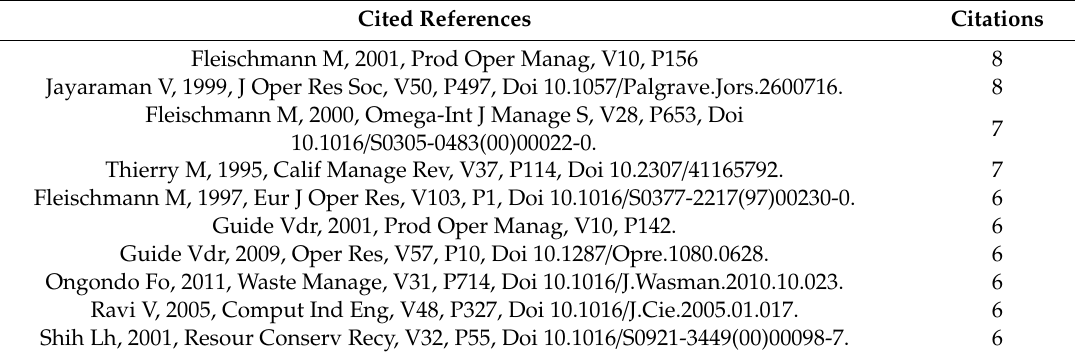
Table 5. Citation analysis: Top 10 most frequent cited manuscripts.